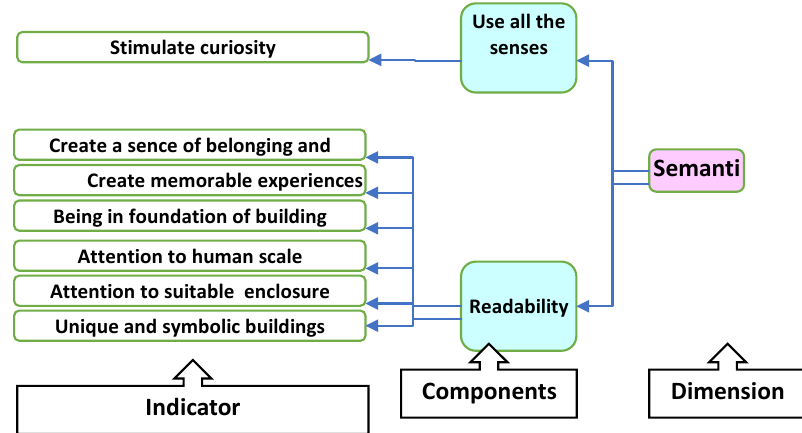
Fig 4: Semantic effective factors on social interaction promotion